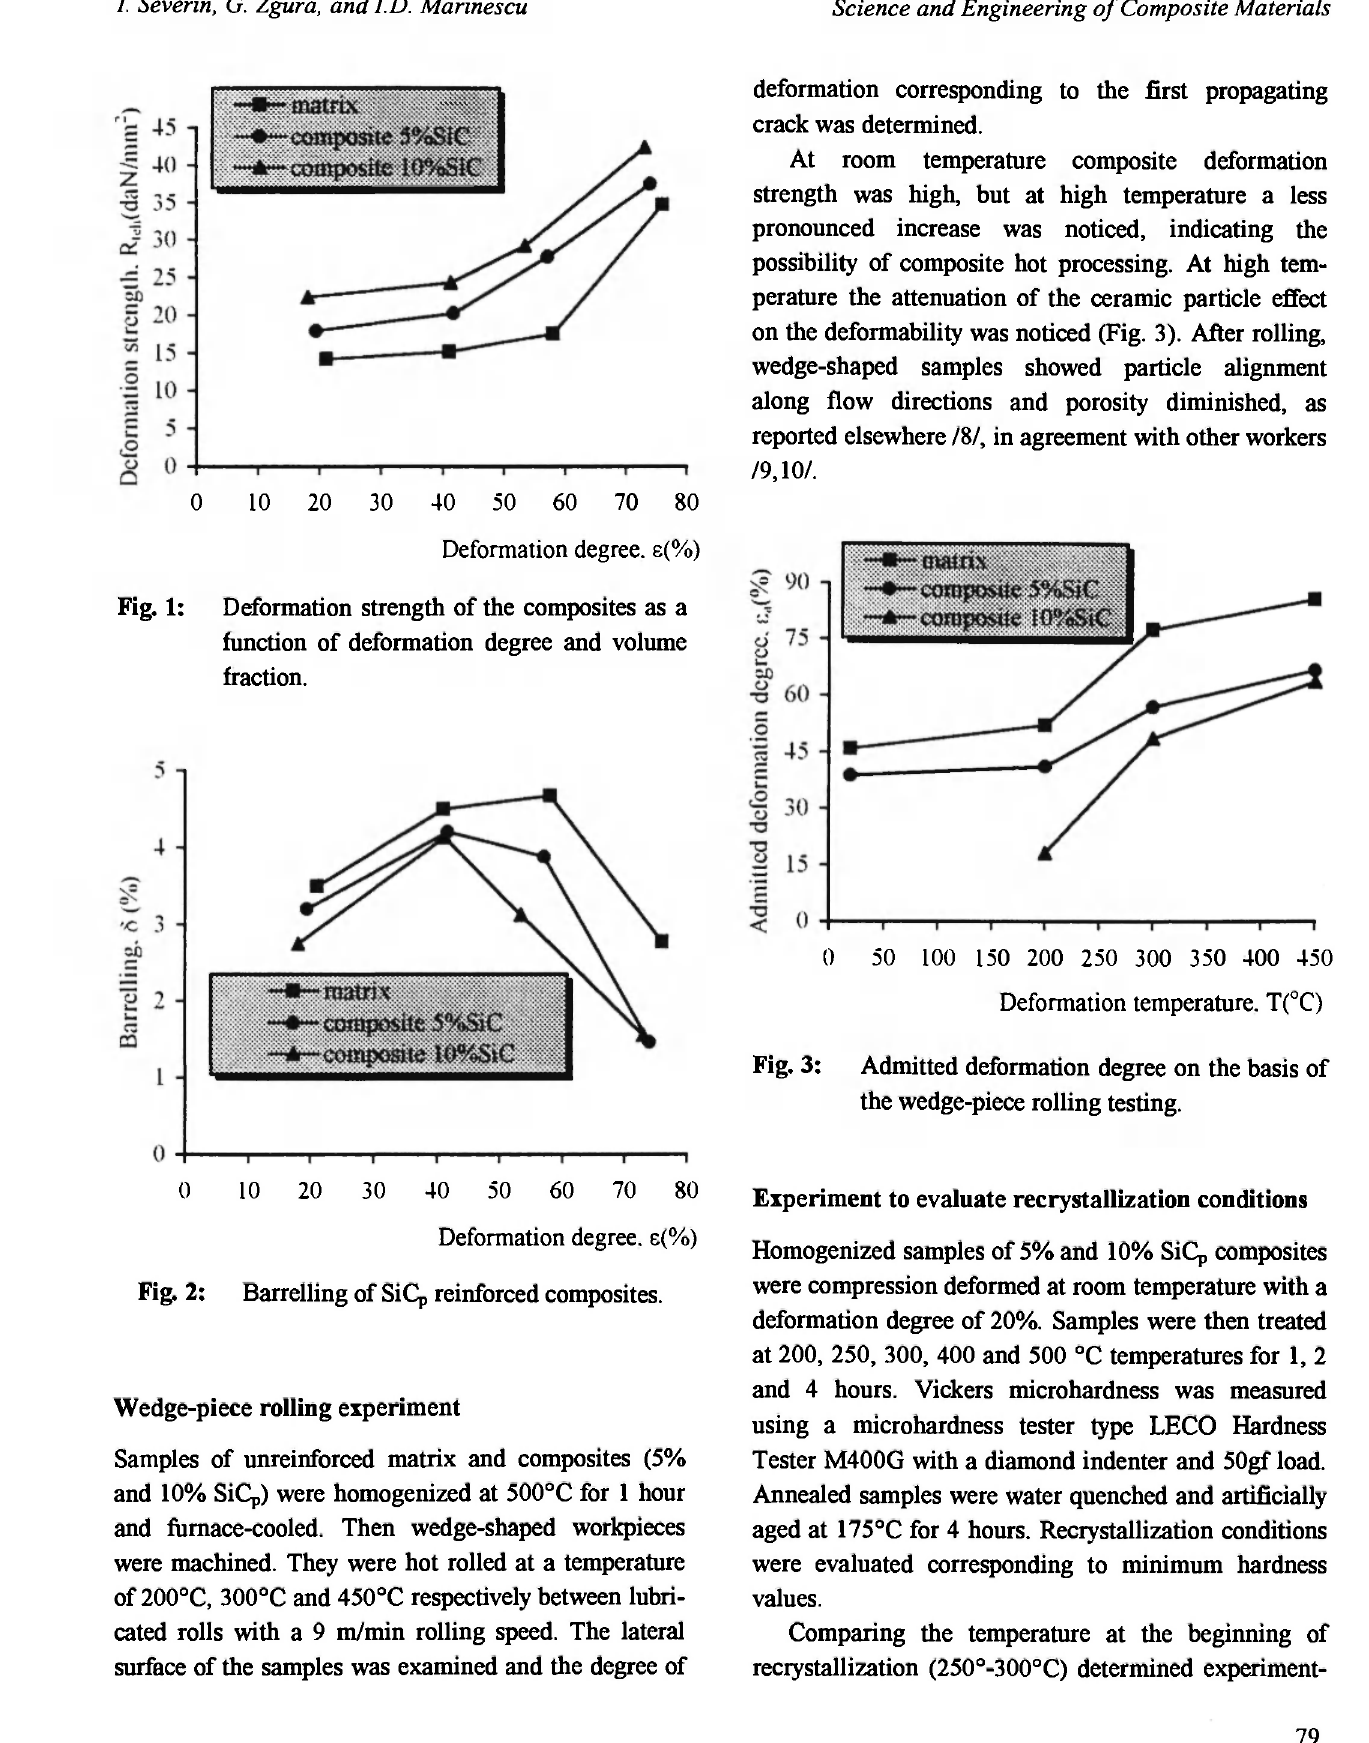
Fig. 2: Barrelling of SiCp reinforced composites. Wedge-piece rolling experiment Samples of unreinforced matrix and composites (5% and 10% SiCp) were homogenized at 500°C for 1 hour and furnace-cooled. Then wedge-shaped workpieces were machined. They were hot rolled at a temperature of 200°C, 300°C and 450°C respectively between lubri- cated rolls with a 9 m/min rolling speed. The lateral surface of the samples was examined and the degree of